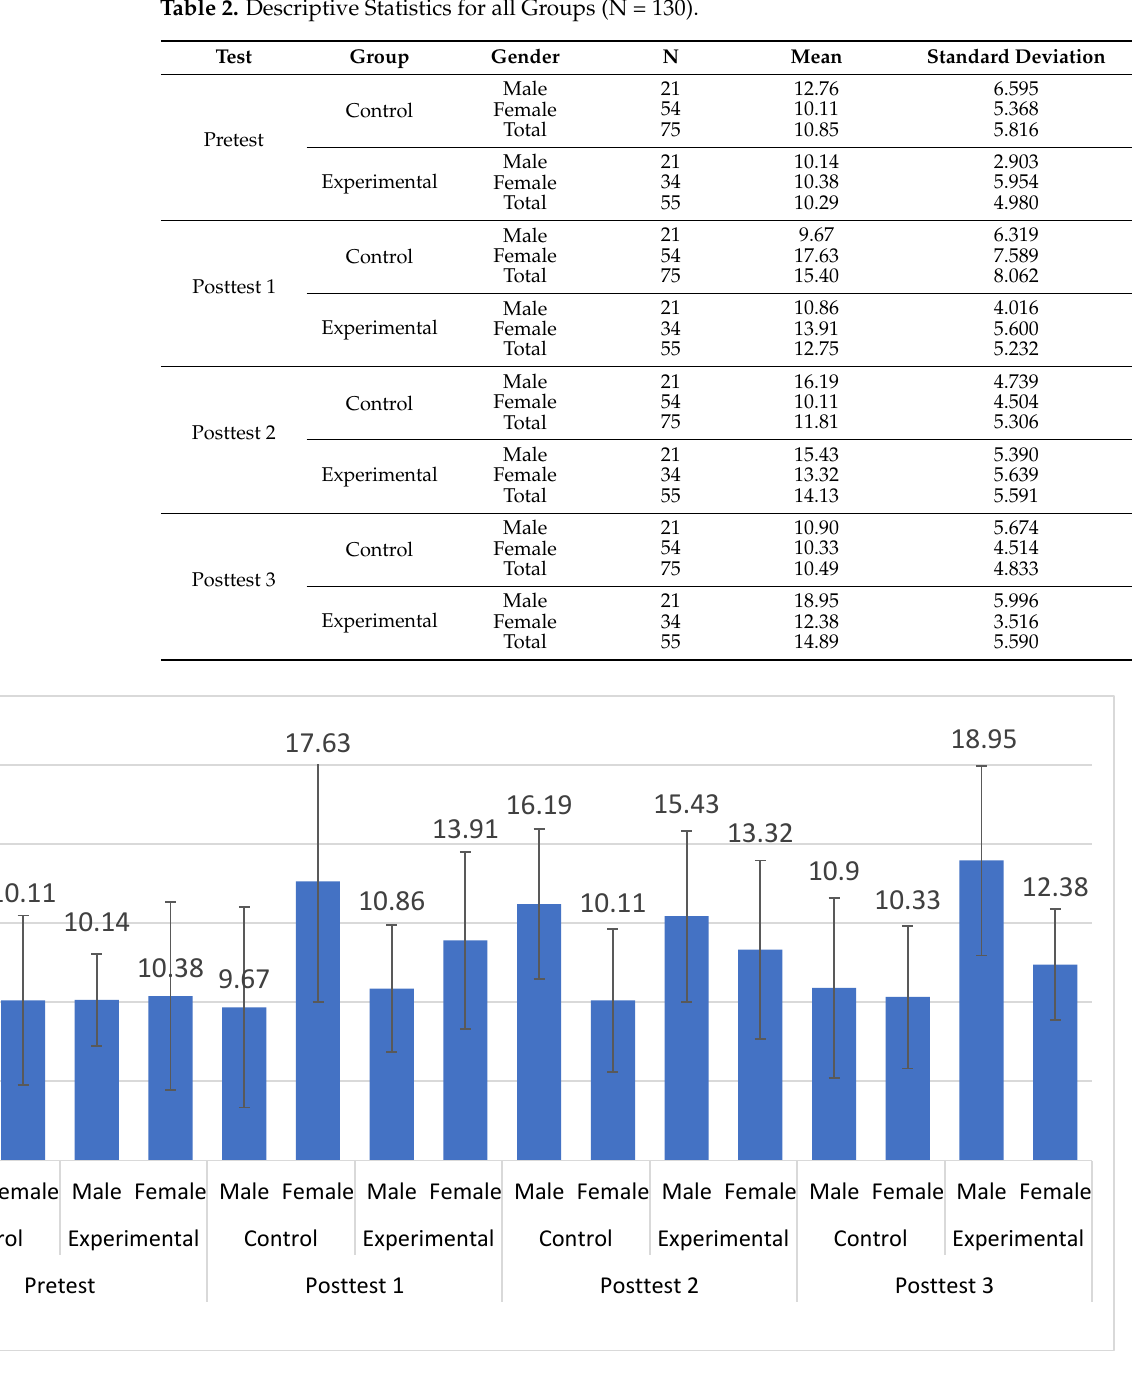
Figure 2. Descriptive Statistics for all Groups.